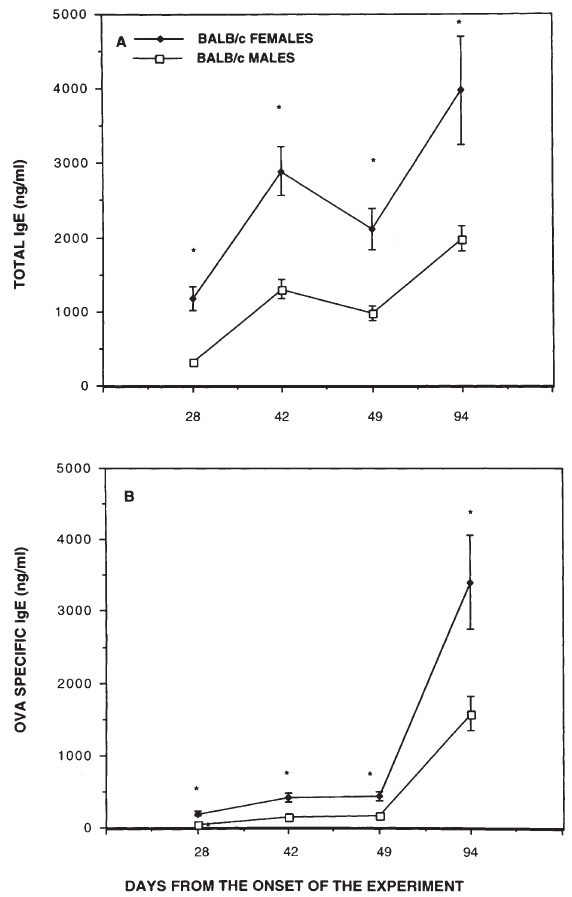
FIGURE 2 IgE levels of OVA immunized BALB/c mice exposed to ambient air. Mice were divided into two groups ð n ¼ 20 Þ : On day 0, all mice were immunized IP with OVA/AL followed by a 20mm exposure to a 1% aerosolized OVA on days 14, 28 and 80. Micewere bled and the sera were tested for (A) total IgE in ng/ml. (B) OVA specific IgE ng/ml. Asterisks indicate p , 0 : 05